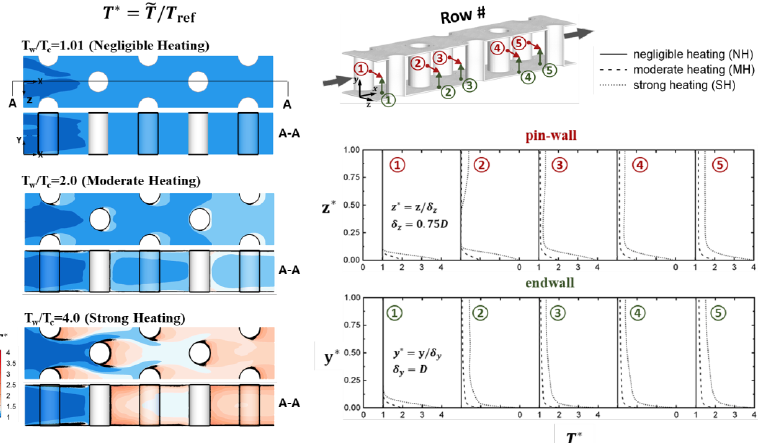
Figure 13. Mean temperature contours and profiles for T w /T c = 1.01 (NH), 2.0 (MH), and 4.0 (SH). Energies 2023 , 16 , 1215